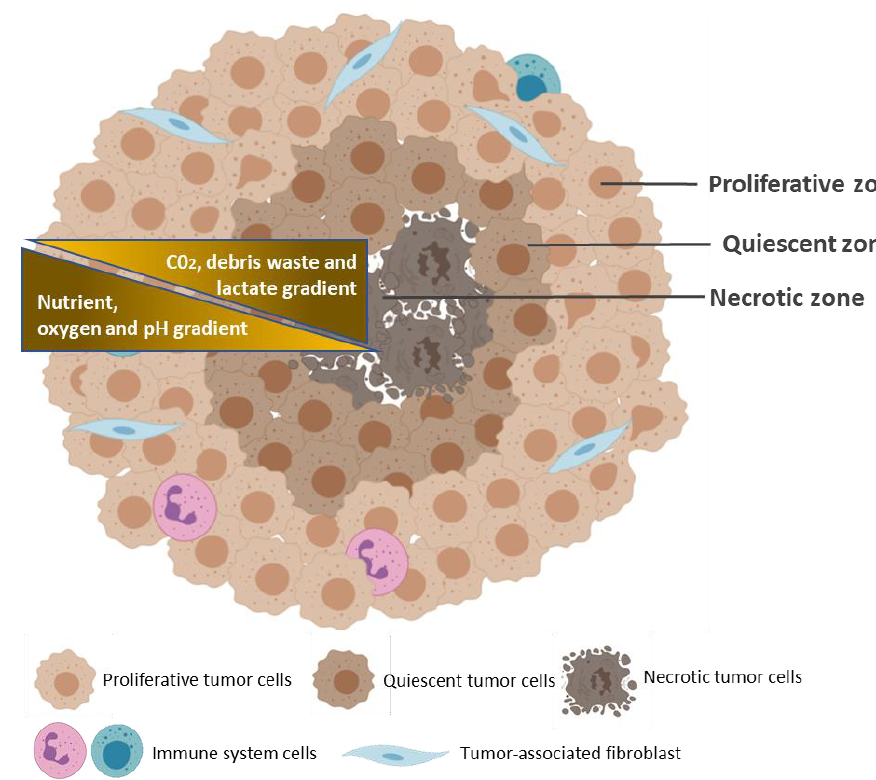
Figure 2. Typical structure of a multicellular tumor spheroid. The geometric rearrangement of the cells within the spheroid forms three concentric zones of heterogeneous cell populations: an external proliferating zone (Proliferative zone); a middle zone of quiescent cells (Quiescent zone), and an internal zone of necrotic cells (Necrotic zone). These cell layers are caused by the gradients of nutrients, oxygen, and pH (yellow), from the outside to the center of the spheroid, and by the gradients of CO 2 , waste, and lactate, from the center to the outside. Created with BioRender.com.